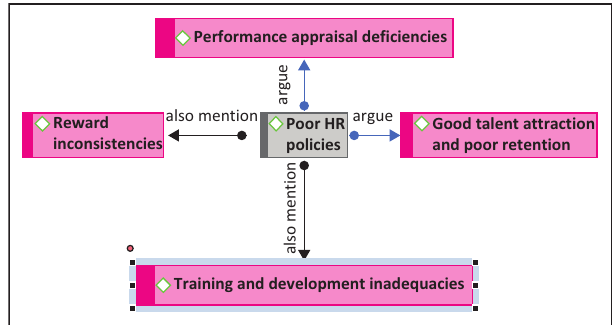
FIGURE 2: Poor human resource policies theme and supporting codes or